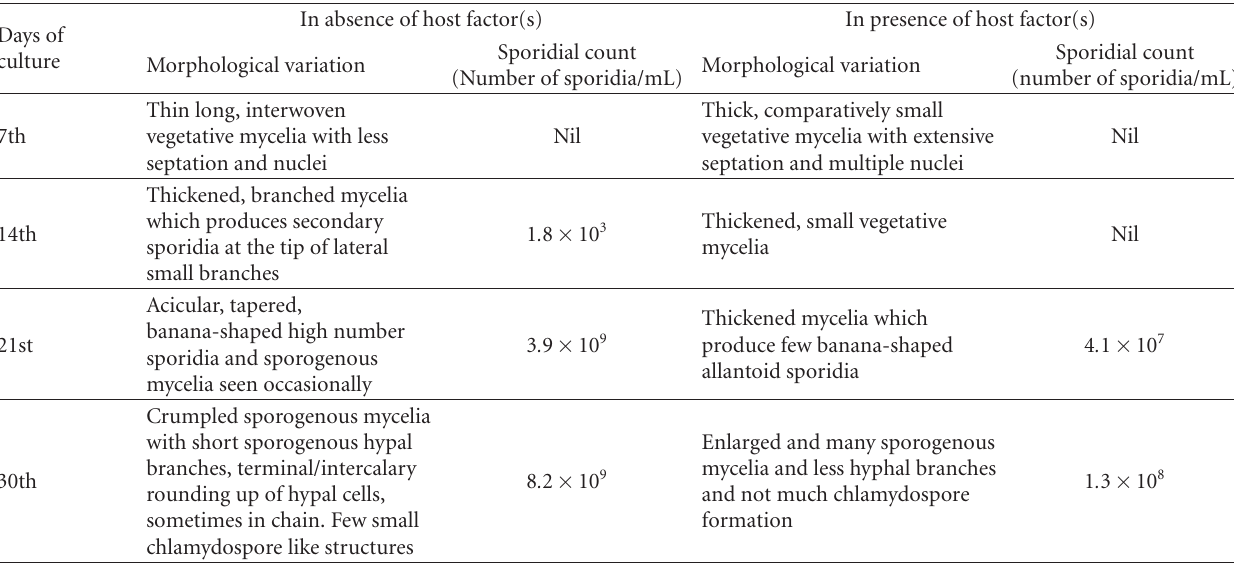
Table 2: Determination of morphological variation and sporidial count of T. indica isolate grown in presence and absence of host